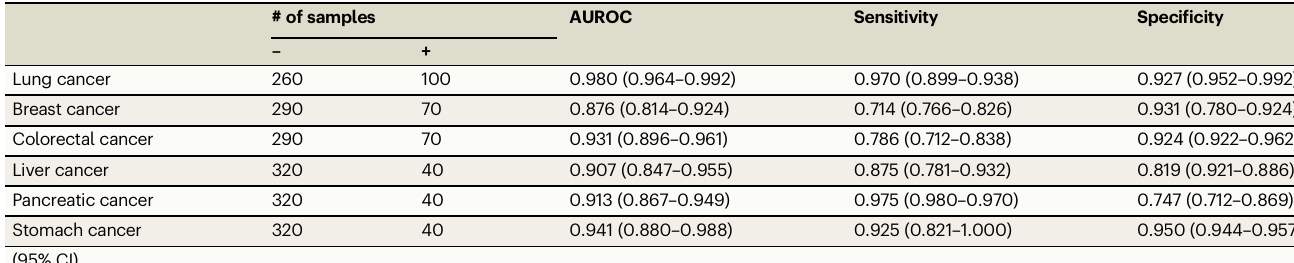
Table 2 | TOO performance for test samples # of